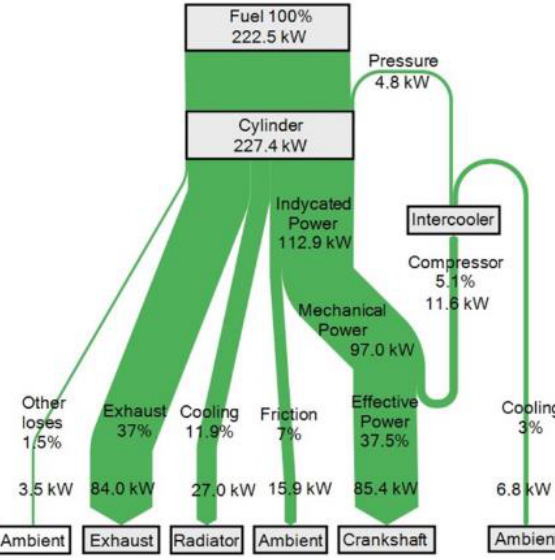
Fig. 2. Sankey's energy balance graph of OPEs aircraft engine with its mechanical compressor – Rotrex C30-64